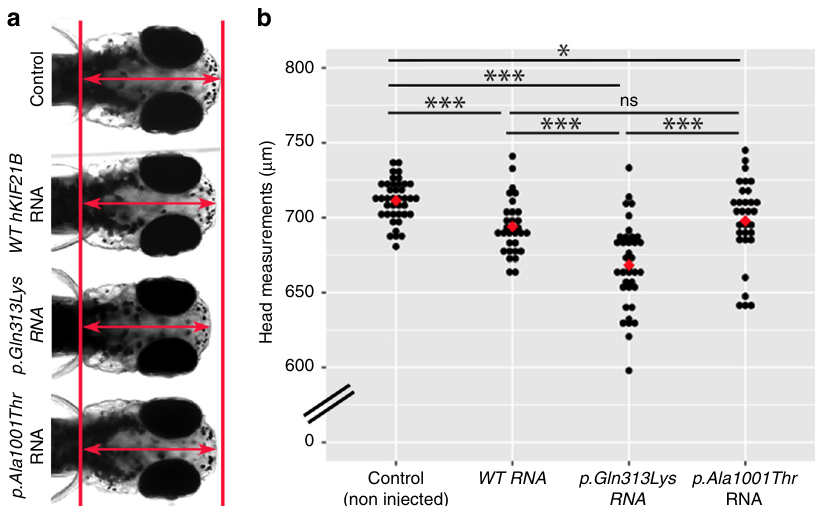
Fig. 5 Expression of p.Gln313Lys hKIF21B decreases head size in zebra fi sh larvae. a Dorsal view of representative control zebra fi sh larvae (non-injected) or injected with 100 pg of wild-type (WT) or mutated hKIF21B mRNAs (p.Gln313Lys and p.Ala1001Thr) at 5 days post-fertilization (5 dpf). Double arrow indicates the distance between the forebrain and hindbrain, a measure used as a proxy for head size. b Dot plot of the head measurements (red double arrow) of control and injected larvae at 5 dpf. Red diamond corresponds to the mean of the batch measured. Number of embryos analyzed for this speci fi c batch: control, n = 40; WT, n = 31; p.Gln313Lys, n = 38; p.Ala1001Thr, n = 31. Experiments were repeated six times for non-injected control embryos ( n = 231), four times for WT-injected embryos ( n = 127), three times for p.Gln313Lys-injected embryos ( n = 108) and four times for p.Ala1001Thr-injected embryos ( n = 158). ns, non-signi fi cant, * P < 0.05, ** P < 0.005, *** P < 0.001. Signi fi cance was calculated by unpaired two-tailed Student ’ s t -test or a Welch ’ s two sample t -test between control and RNA-injected larvae. ns non-signi fi cant, * P < 0.05, ** P < 0.005, *** P < 0.001. Source data are provided in the Source Data fi